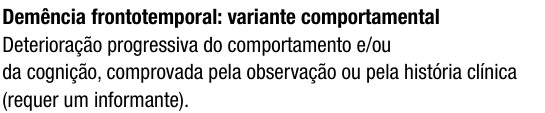
Tabela 1. Critérios Diagnósticos para Demência